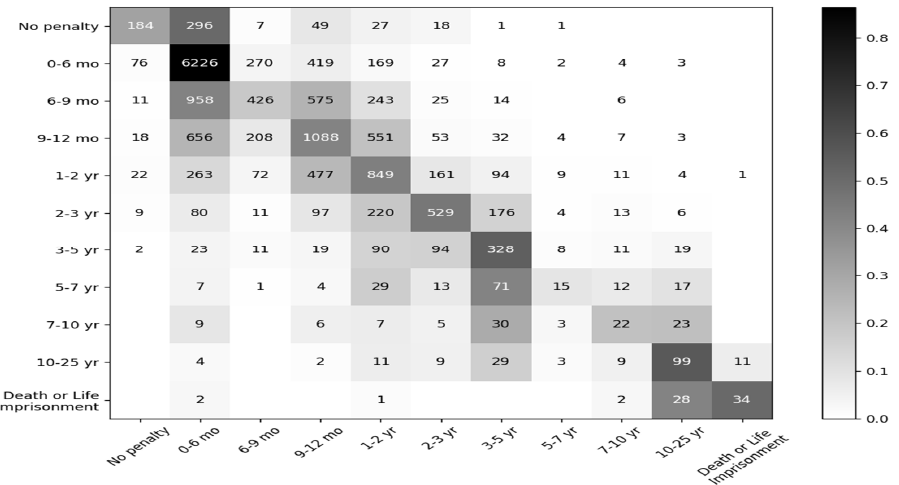
Figure 8. A confusion matrix of the sentence prediction results of CAIL-big. Note: The rows represent predicted classifications and the columns describe true classifications.